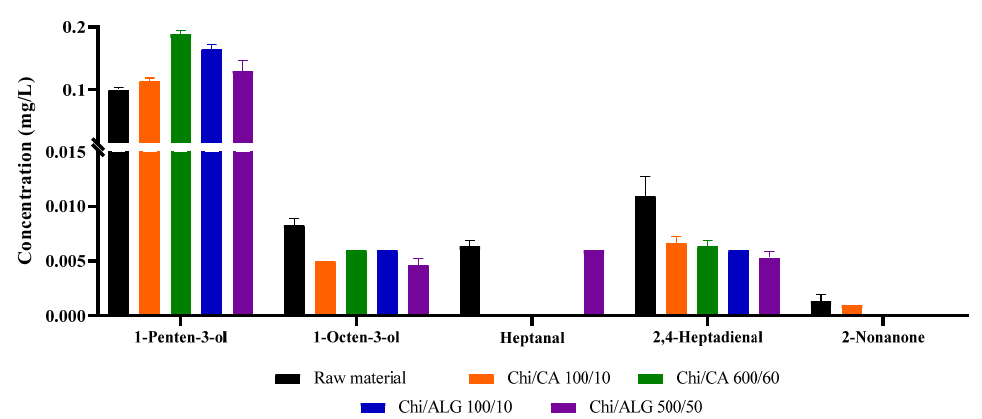
Figure 12. Aroma characterisation of the RO retentates for different coagulation/flocculation com- binations. Focusing on the obtained permeates, Figure 13 presents the values of COD obtained, in order to evaluate the possibility of reusing the permeate as process water.